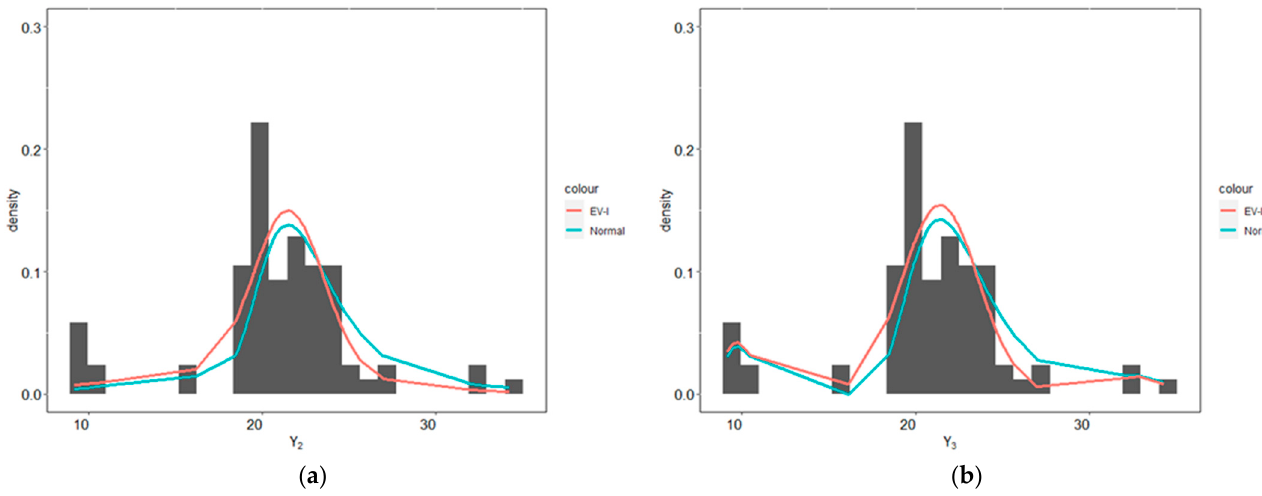
Figure 7. Predictive densities for acidity data using the EV-I mixture and the Gaussian mixture distributions with ( a ) two components, ( b ) three components, ( c ) four components, ( d ) five components, ( e ) six components, and ( f ) seven components.